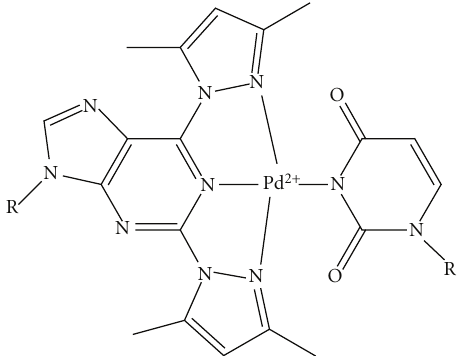
Figure 3: Proposed ternary complex between 1 , Pd 2+ , and